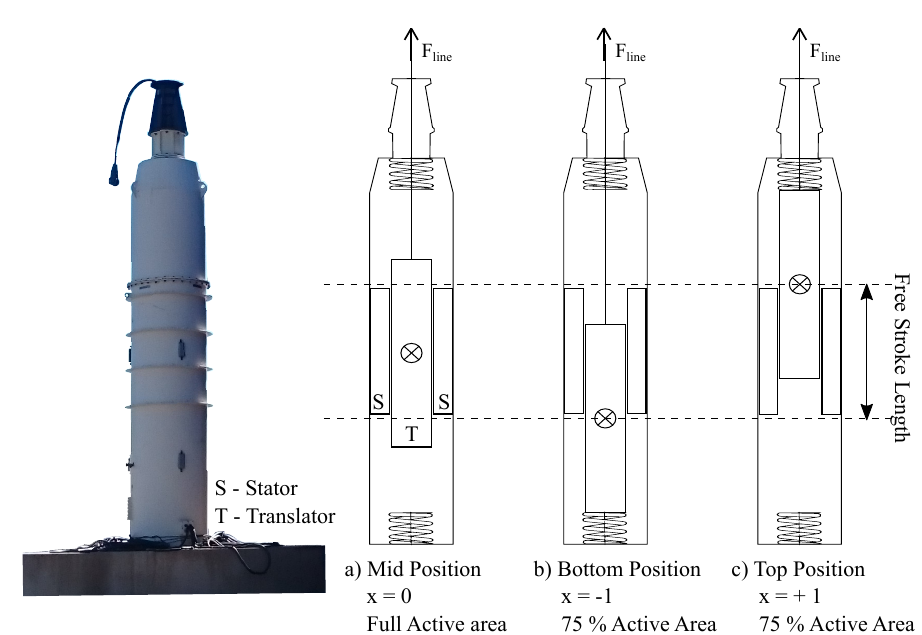
Figure 1. The L10 generator and a sketch of it with the translator at ( a ) mid position, whith full stator overlap; ( b ) the lower endstop, where A fac = 75%; and ( c ) at the upper endstop, where A fac = 75%.